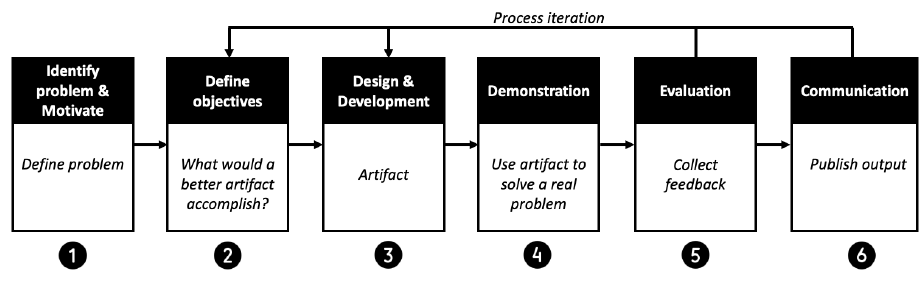
Figure 2. Design science research